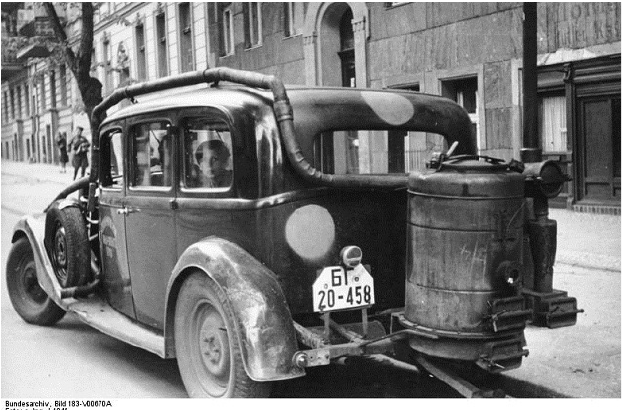
Figure 1 . A WWII car with woodgas generator